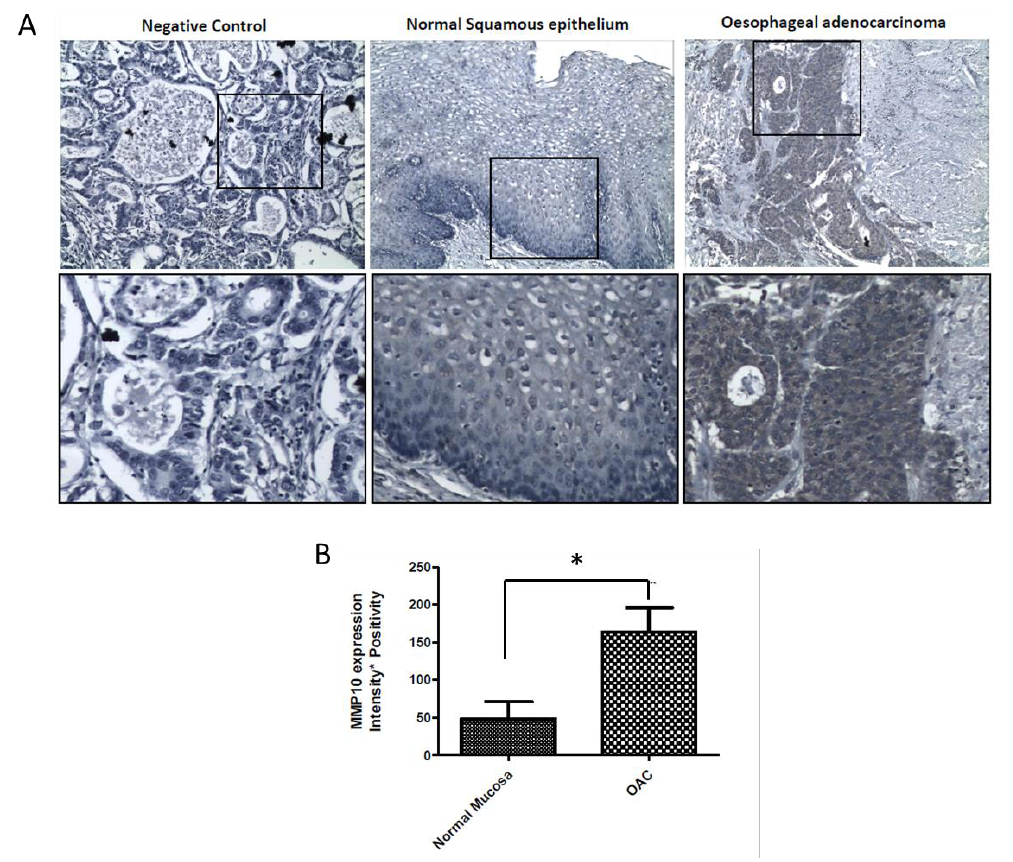
Figure 6. ( A ) Representative images of MMP10 immuno-histochemical staining of normal squamous epithelium ( n = 4 patients) and oesophageal adenocarcinoma (OAC) tissue ( n = 8 patients). A negative control was included where the primary antibody was replaced with normal goat serum during the immunohistochemistry staining. ( B ) Quantitative analysis (* p < 0.05 versus normal squamous epithelium).